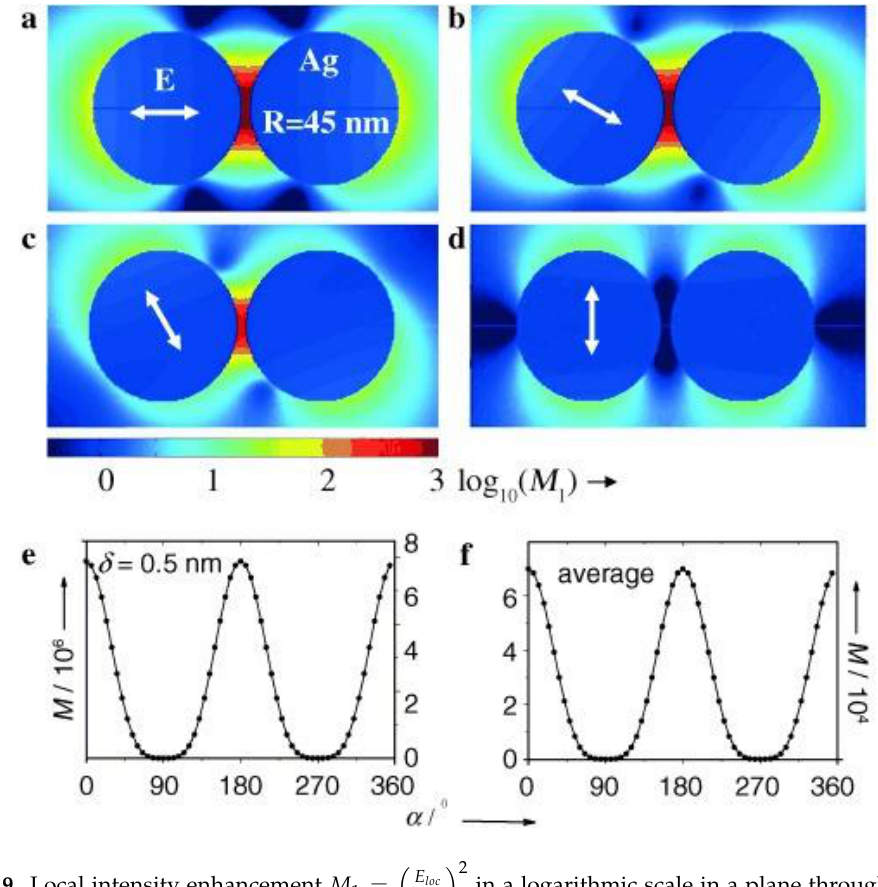
) 2 in a logarithmic scale in a plane through the Figure 9. Local intensity enhancement 𝑀 1 = ( 𝐸 𝑙𝑜𝑐 (cid:16) (cid:17) 2 𝐸 0 E loc Figure 9. Local intensity enhancement M 1 = in a logarithmic scale in a plane through the E 0 centers of the Ag spheres and perpendicular to the incident wavevector 𝑘⃗ versus incident → k versus incident polarization: centers of the Ag spheres and perpendicular to the incident wavevector polarization: ( a ) 0°; ( b ) 30°; ( c ) 60° and ( d ) 90°. The incident wavelength was 514.5 nm in all cases. The ( a ) 0 ◦ ; ( b ) 30 ◦ ; ( c ) 60 ◦ and ( d ) 90 ◦ . The incident wavelength was 514.5 nm in all cases. The arrows arrows represent the different polarizations. In ( e ), the SERS enhancement factor 𝑀 = 𝑀 12 is shown as represent the different polarizations. In ( e ), the SERS enhancement factor M = M 2 is shown as a a function of the incident polarization 𝛼 for a point in the nanogap located at the dimer axis 𝛿 = 0.5 1 function of the incident polarization α for a point in the nanogap located at the dimer axis δ = 0.5 nm nm away from one spherical surface, and the fit (solid line) to a cos 4 𝛼 dependence. In ( f ), 𝑀 averaged away from one spherical surface, and the fit (solid line) to a cos 4 α dependence. In ( f ), M averaged over all points 𝛿 = 0.5 nm outside the Ag sphere surface versus 𝛼 and fit to a cos 4 𝛼 dependency are over all points δ = 0.5 nm outside the Ag sphere surface versus α and fit to a cos 4 α dependency are shown. The radius 𝑅 = 45 nm corresponds to the average size of the Ag nanoparticles used in the shown. The radius R = 45 nm corresponds to the average size of the Ag nanoparticles used in the experiment while the separation distance 𝑑 = 5.5 nm corresponds to the diameter of a hemoglobin experiment while the separation distance d = 5.5 nm corresponds to the diameter of a hemoglobin molecule. Reprinted with permission from [54]. molecule. Reprinted with permission from